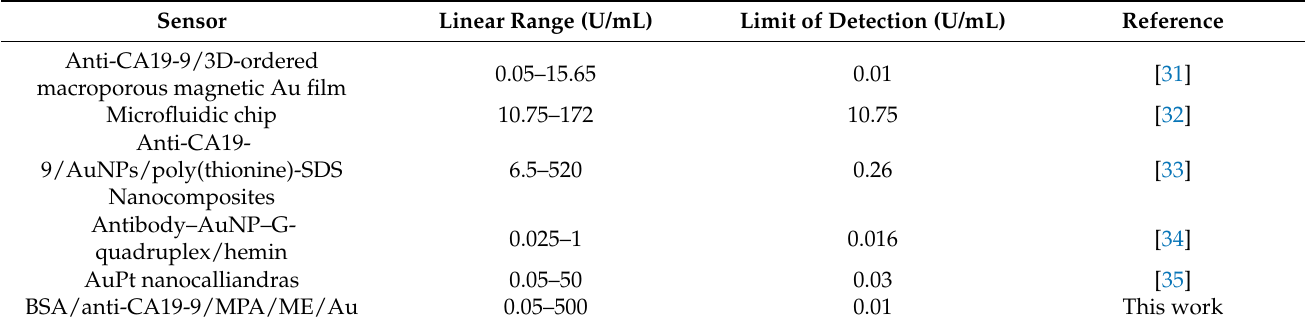
Figure 5. ( A ) DPV curves of BSA/anti-CA19-9/MPA/ME/Au towards 0, 0.05, 0.5, 5, 10, 50, 100, and 500 U/mL. ( B ) Plots of ∆ I against the logarithm of concentration. Table 2. Comparison of BSA/anti-CA19-9/MPA/ME/Au with previous published electrochemical immunosensors for CA19-9